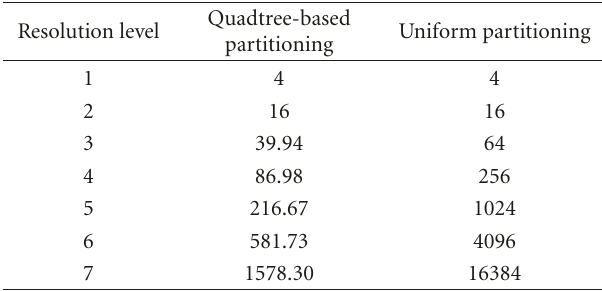
Table 9: Number of bins at di ff erent resolution levels using the quadtree-based and uniform partitioning method.